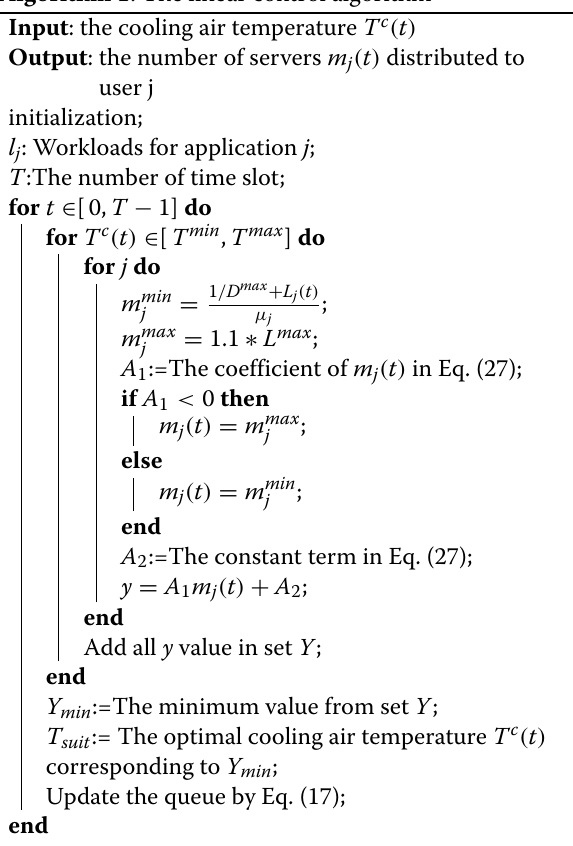
Algorithm 1: The linear control